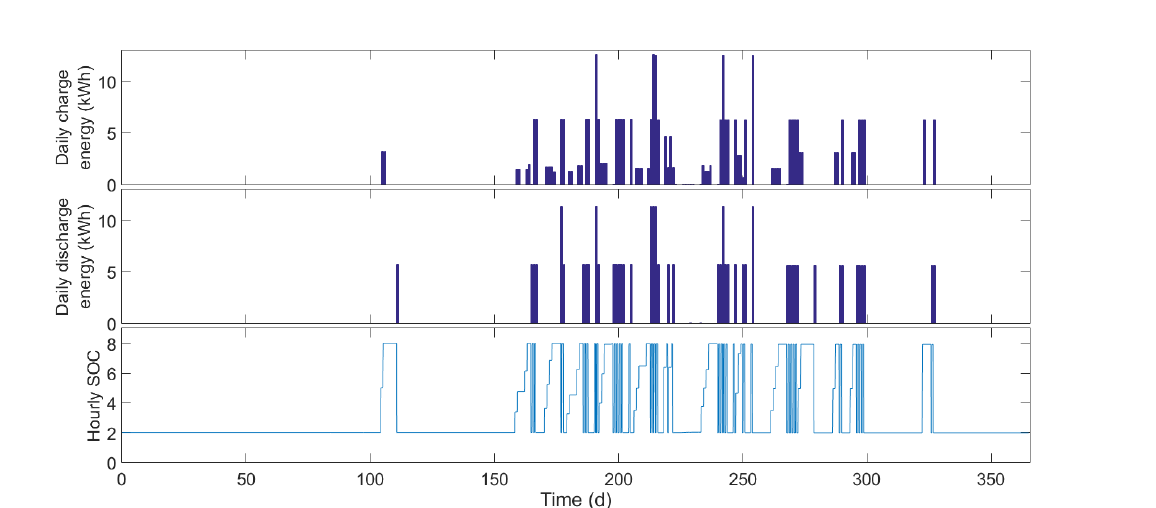
Figure 7. Optimal operation for a “complex tariff” example during a year period and a battery price of 300